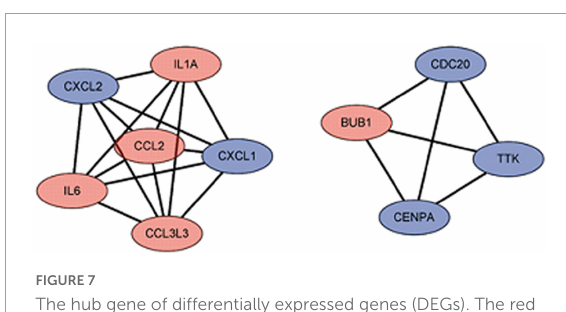
FIGURE7 The hub gene of differentially expressed genes (DEGs). The red represents the up-regulated genes. The blue represents the down-regulated